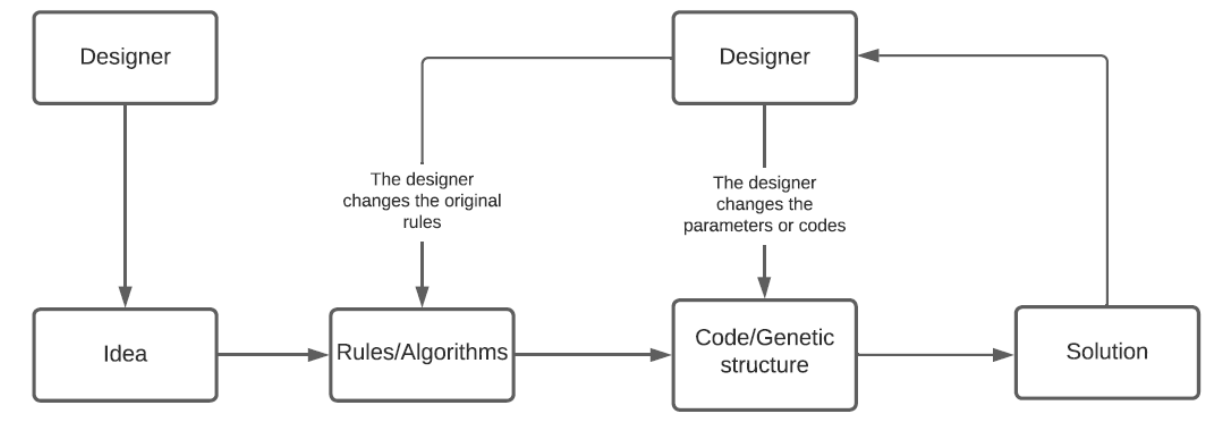
Figure 1. Generative design process. Source: adapted from [35].